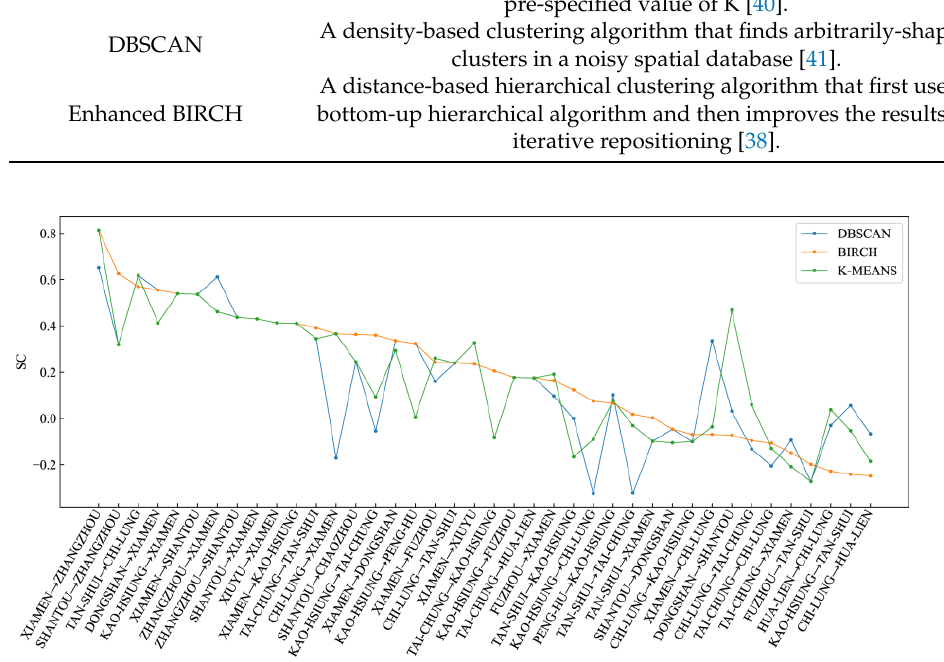
Figure 13. Comparison of SC evaluation indices for different clustering algorithms.